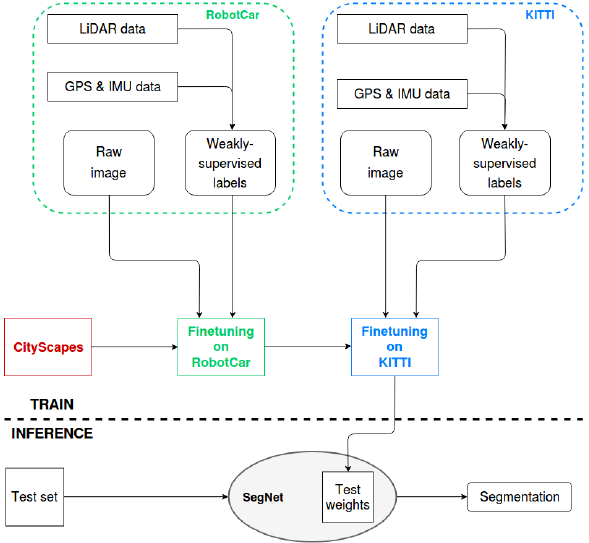
Figure 2: The main workflow of the applied